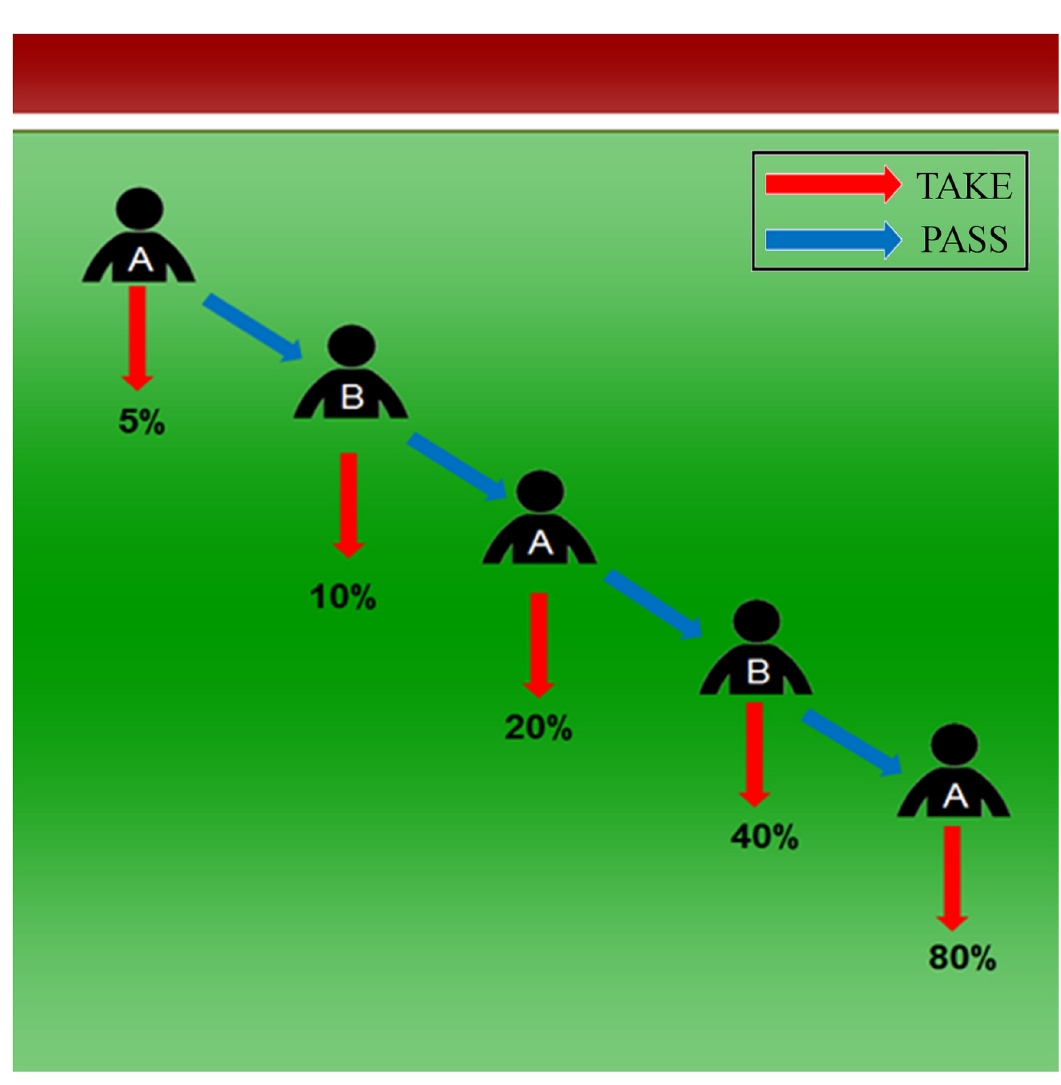
Fig 2. Illustration of the probabilistic variant of the centipede game. Passing doubles the group’s chance of achieving a success while taking secures an individual the possibility to receive the higher payoff, which is € 160 for the subject who takes compared to only € 40 for the other